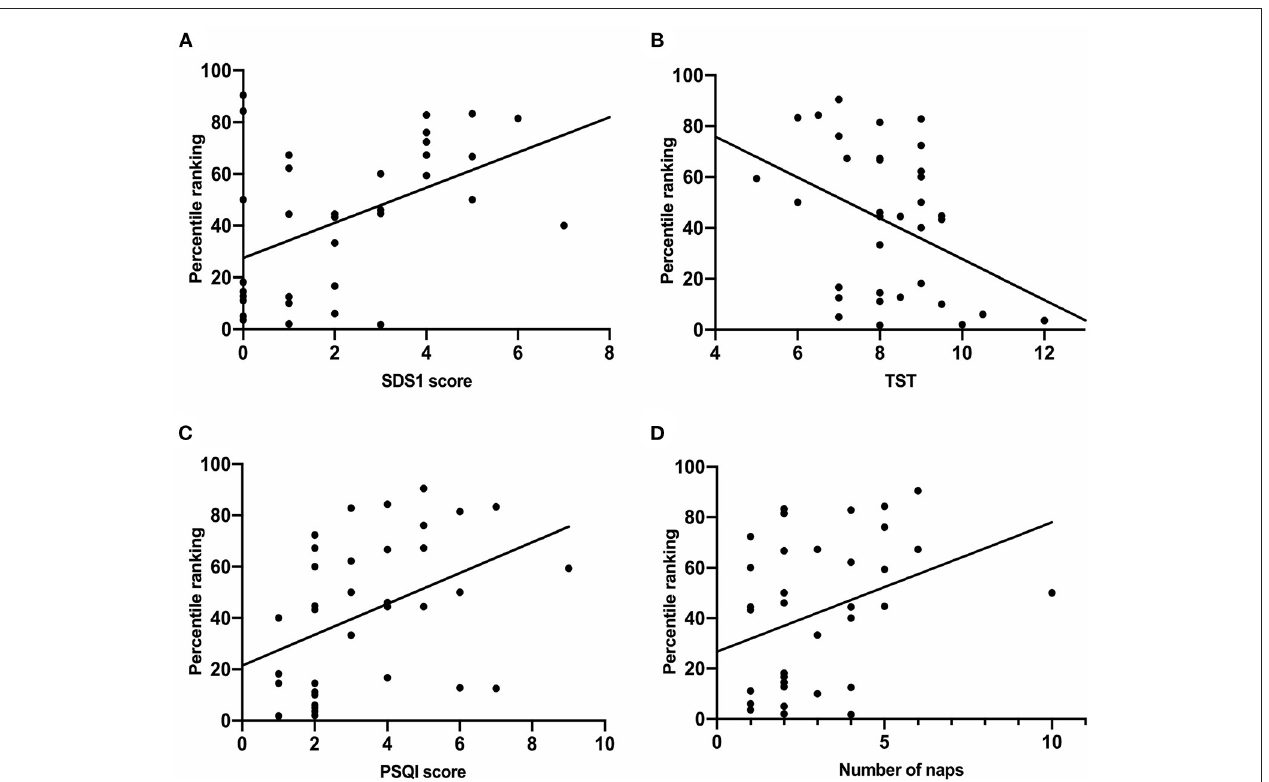
FIGURE 2 | Linear regression analysis of the percentile ranking and various sleep behavior indices in narcolepsy group. (A) The percentile ranking of students is significantly positively correlated with SDS1 ( R = 6.811; 95%CI: 2.351, 11.271; P = 0.04). (B) The percentile ranking of students is significantly positively correlated with PSQI score ( R = 6.012; 95%CI: 1.405, 10.620; P = 0.012). (C) The percentile ranking of students is significantly positively correlated with numbers of naps ( R = 5.122; 95%CI: 0.221, 10.022; P = 0.041). (D) The percentile ranking of students is significantly positively correlated with TST ( R = − 8.019; 95%CI: −